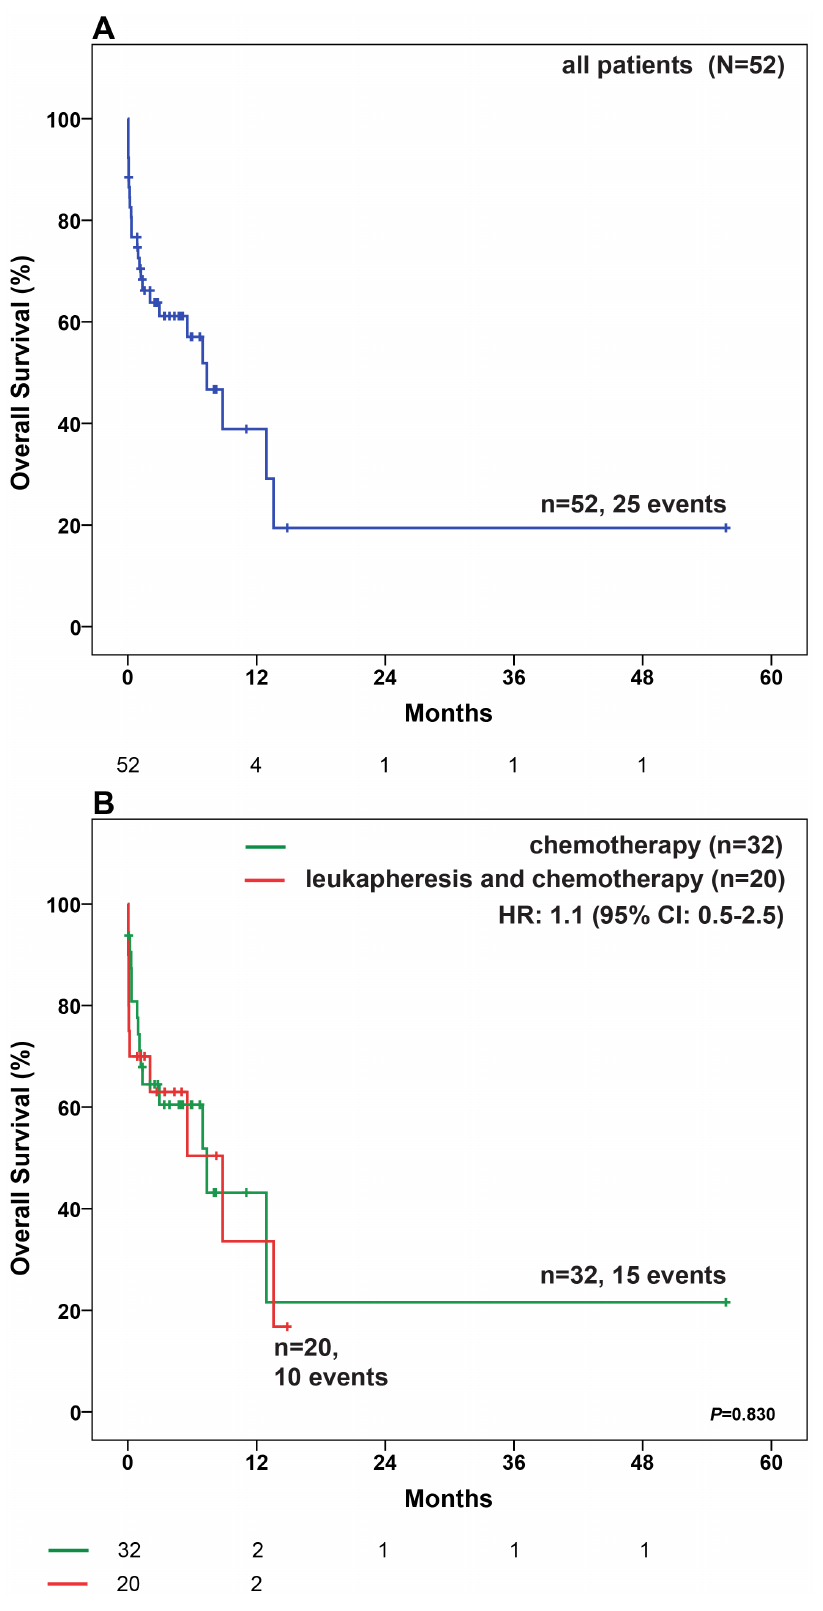
Figure 2. OS in patients with WBC $ 100 G/l. (A) in all patients (B) in patients who received either chemotherapy only or chemotherapy combined with leukapheresis. Median OS was 7.4 months (95% CI: 4.1–10.6 months) in all patients, 7.4 months (95% CI: 1.3–13.4 months) in patients receiving chemotherapy only and 8.8 months (95% CI: 1.3–16.4 months) in patients with the combination of chemotherapy and leukapheresis. Abbreviations: CI, confidence interval; HR, Hazard Ratio, OS, Overall survival; doi:10.1371/journal.pone.0095062.g002 PLOS ONE |